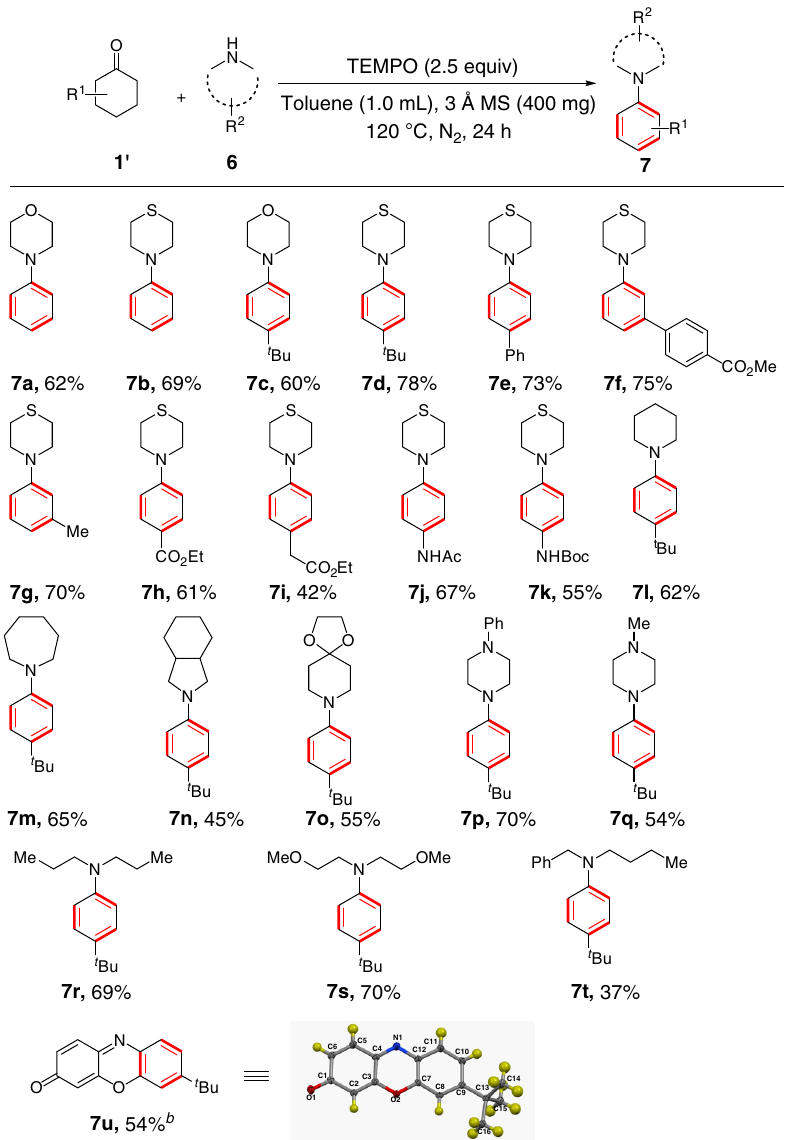
Fig. 4 Reaction of cyclic ketones with secondary amines a . a Reaction conditions: 1 ′ (0.4 mmol), 6 (0.6 mmol), TEMPO (1.0 mmol), 3 Å MS (800 mg), toluene (1.0 mL), N 2 , 120 °C for 24 h. Isolated yields. b TEMPO (2.4 mmol) and 3 Å MS (1000 mg) were